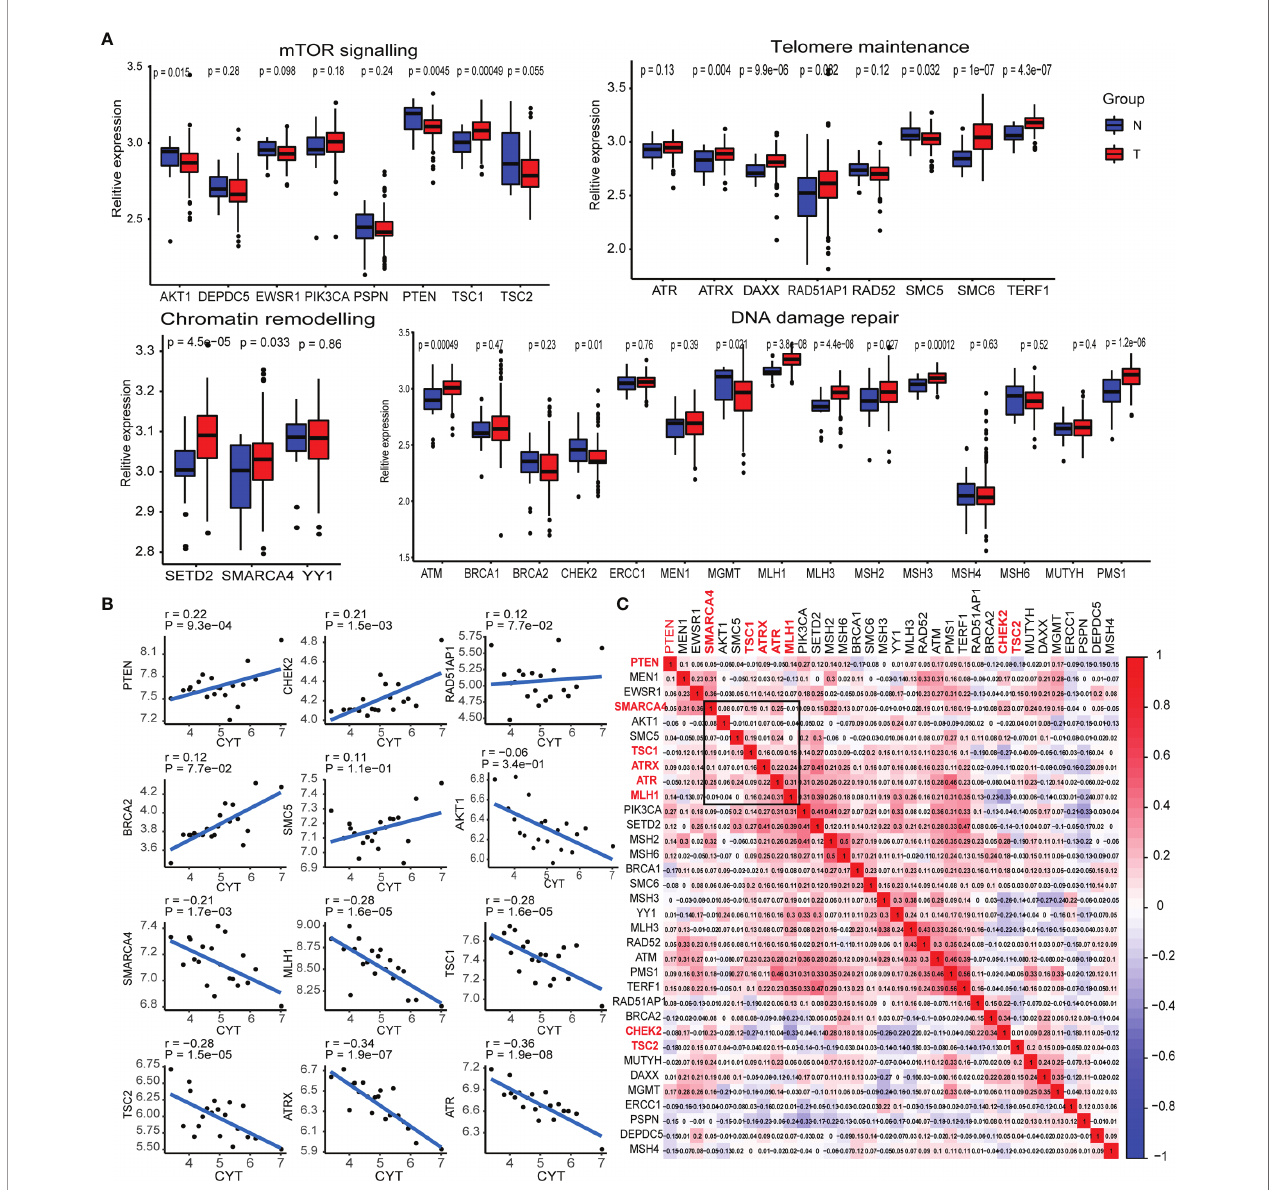
FIGURE 1 | Transcriptional expression of the main pathway-related molecules in GEP-NENs. (A) Box plots show the expression distribution of 34-pathway-related molecules between paired normal (blue) and GEP-NEN (red) tissues. (B) Correlation between pathway-related molecules expression and cytolytic activity in GEP- NENs. (C) Correlation map of pathway-related molecules expression in